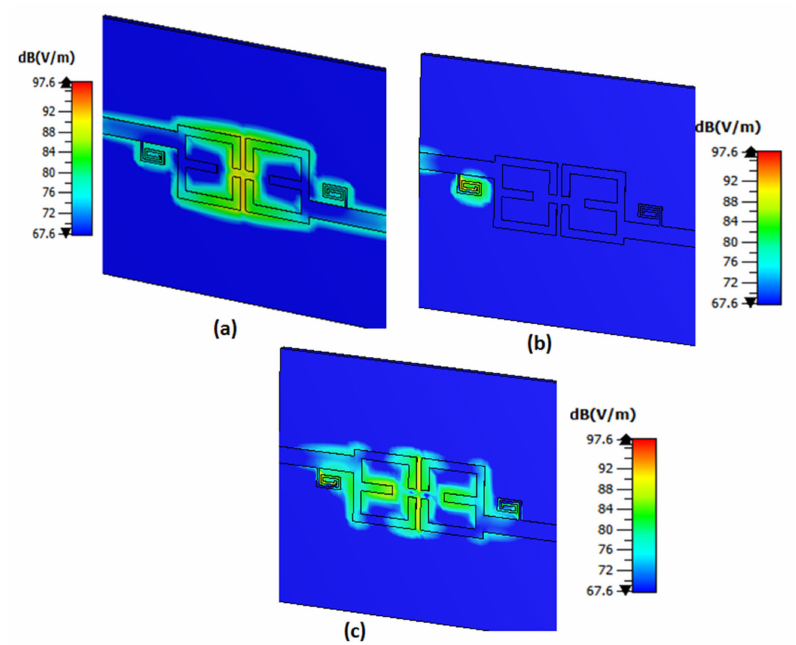
Figure 14. The electric field results of dual-band stub loaded OLR with 0 ◦ feed and two spiral resonators BPF. ( a ) at 3.5 GHz. ( b ) at 5.3 GHz. ( c ) at 6 GHz.